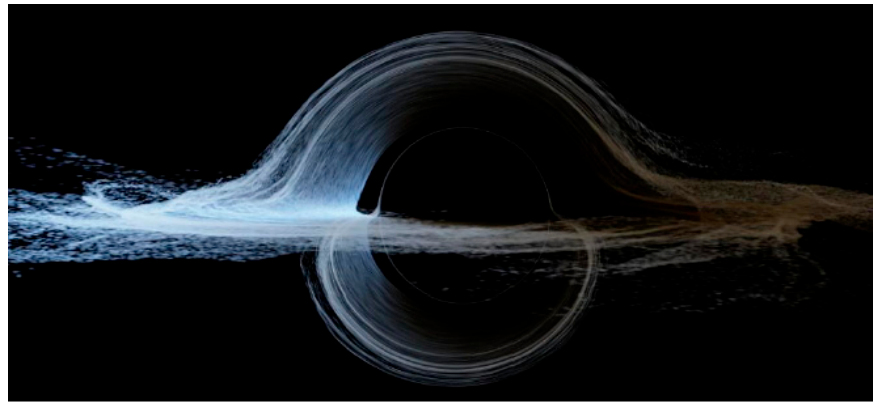
Figure 4. An « anemic » accretion disk around a Kerr black hole with spin a / M = 0.6, false colours, Doppler and gravitational shifts (from [13]).